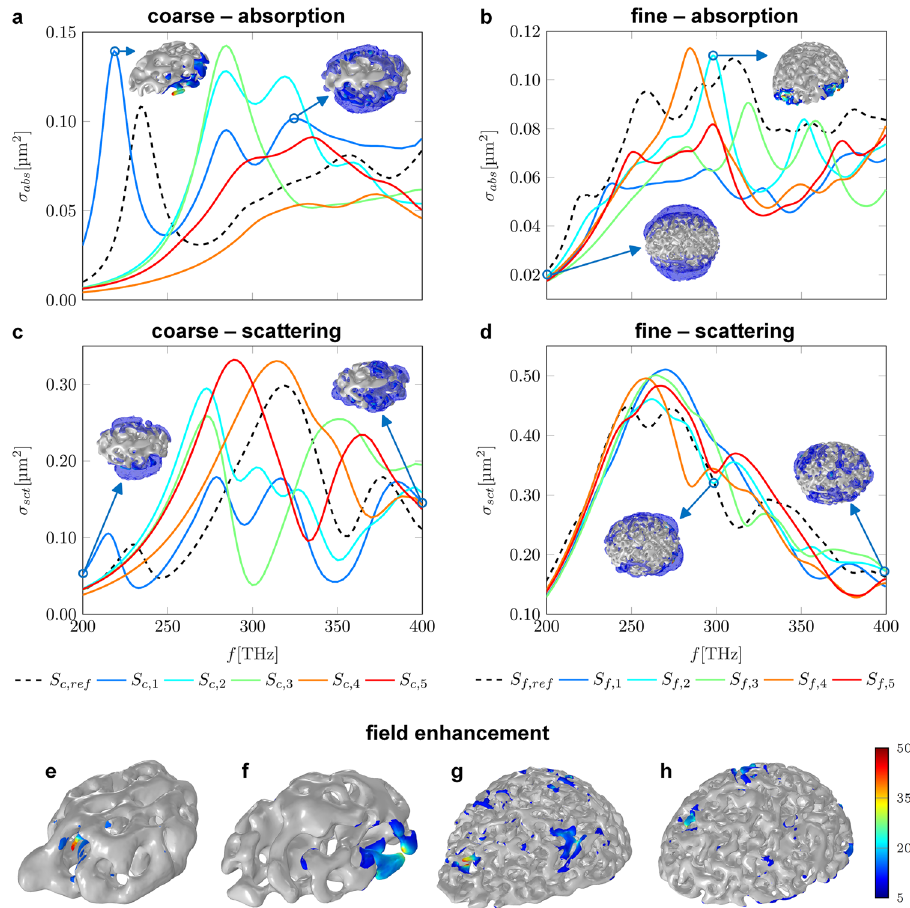
Fig. 6 Calculated optical properties of computer-generated and experimentally measured nanosponge geometries. a , d Calculated absorption a , b and scattering c , d cross sections of reference and phase- fi eld sponges. Shown are spectra of coarse-pored ( a , c ) and fi ne-pored ( b , d ) sponges. Shown in the insets of ( a , d ) are images of the time-averaged fi eld enhancement distribution ∥ E ∥ / E 0 on the sponge surface where it exceeded a factor of 5, as well as ∥ E ∥ / E 0 in the surrounding volume where it exceeded a factor of 3, showing the dipole-like nature of the underlying mode. In the top-left and top-right insets, the volume plots are purposefully left out to better show the fi eld enhancement around the excited hot spots. e – h Comparison of the time-averaged fi eld enhancement distribution ∥ E ∥ / E 0 between reference and simulated sponges. Shown are the sponges ( e ) itself is rendered in gray, while the fi eld enhancement is overlaid in regions where it exceeded a factor of 5. The color bar is truncated at 50 and identical in all fi gures as shown on the